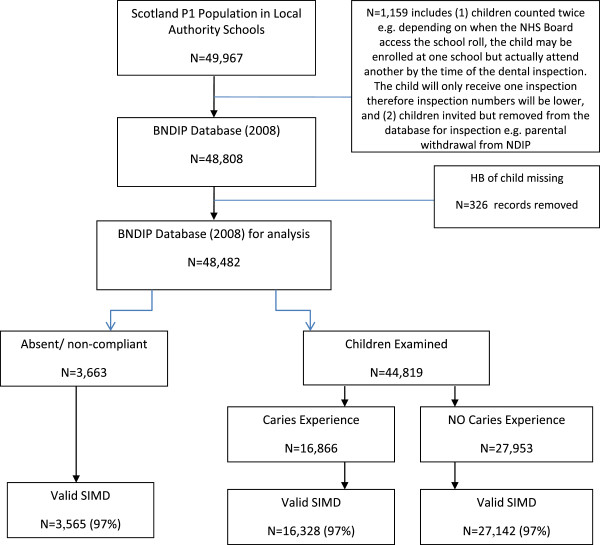
Flow diagram of analysis data.